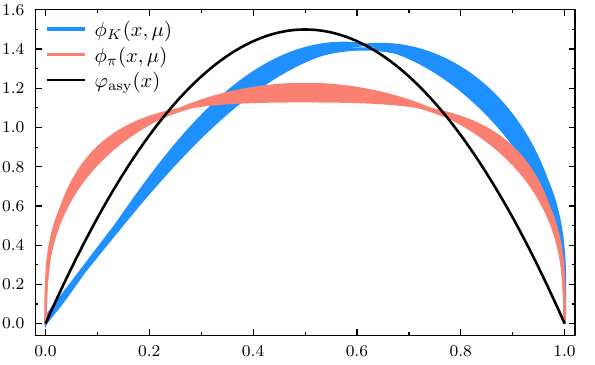
distribution amplitudes with φ D error bands correspond to uncertainties of ω f ± Δω f in the interaction model